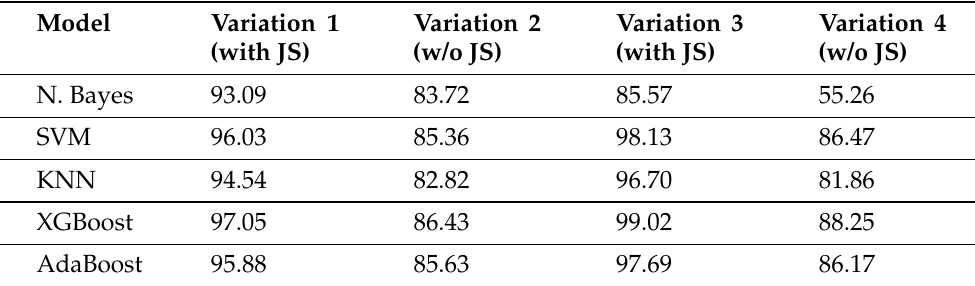
Table 2. Classification accuracy (%) with and without JavaScript features for original and expanded A.K. Singh